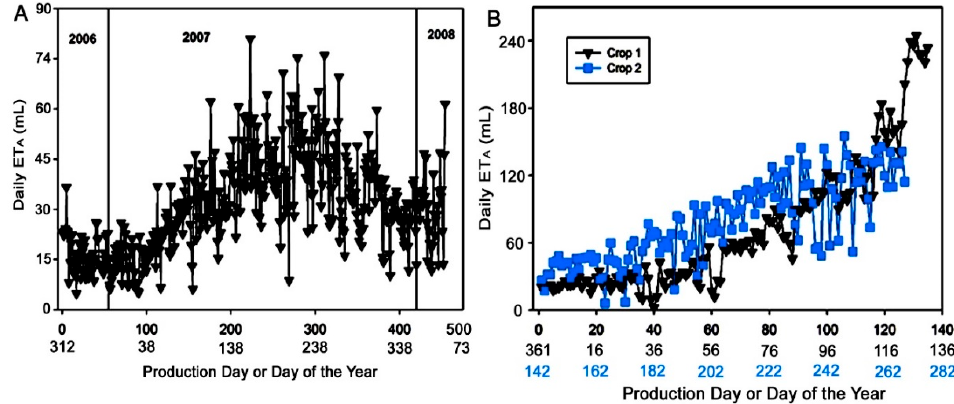
Figure 2. Mean daily ET A of Davallia bullata ( A ) and Nephrolipis exaltata ( B ), this species was produced twice, (i.e., two crops) grown in 15 cm plastic containers during production from liners to marketable sizes. Each point is the mean of four plant replicates.